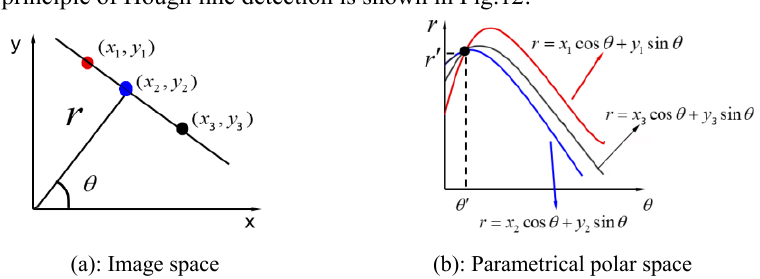
Fig. 12. Transformation from the image space to polar parameter space of Hough line detection.